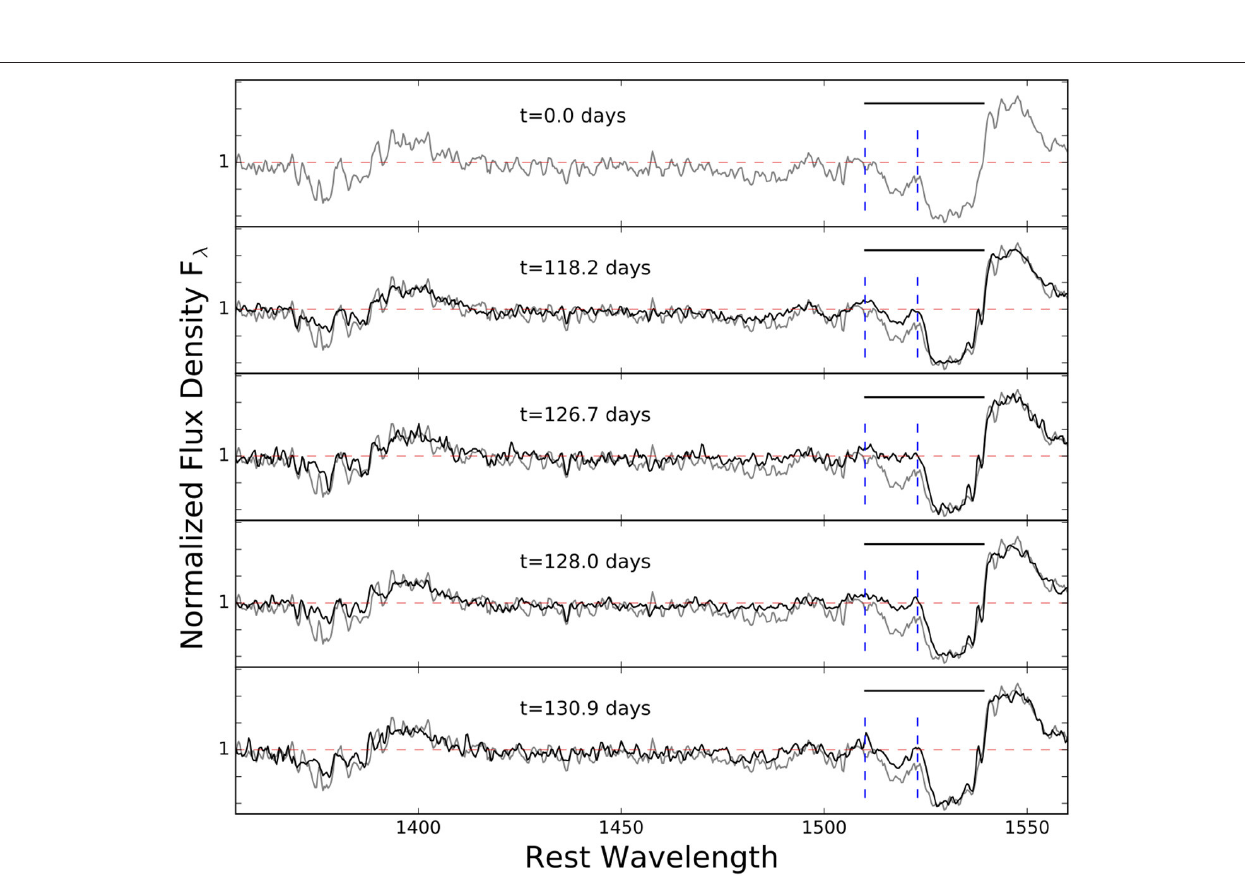
FIGURE 2 | Five epoch observations of J1419 illustrating BAL strength variations. The first epoch spectrum on the top panel is also shown other panels for guidance. The dashed red line indicates the continuum level and the horizontal black line shows C A BAL region. The high velocity component of the trough (C Ab ) is marked with dashed blue lines. Middle panel spectrum at t = 126.7 days presents the disappearance